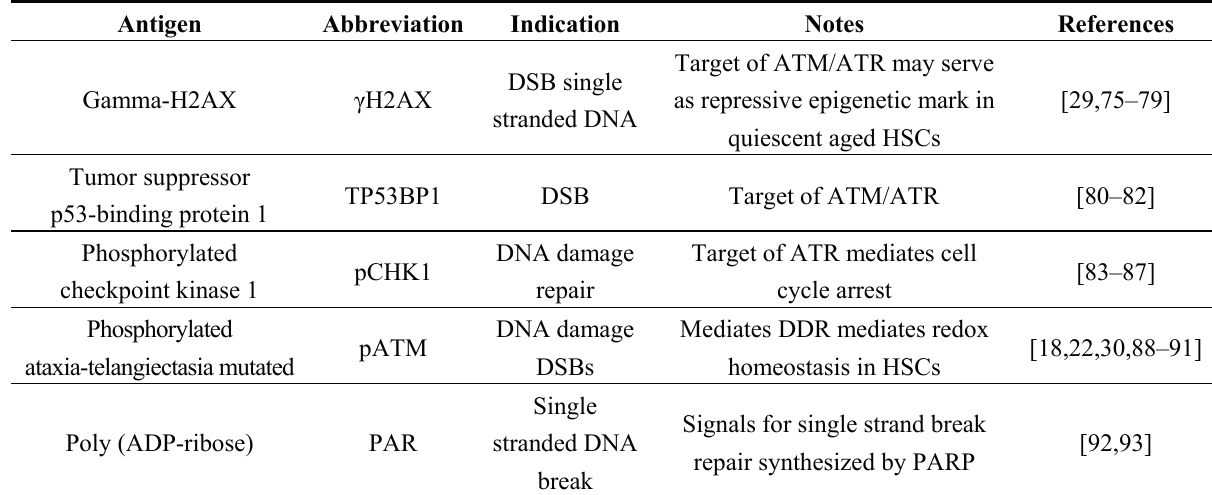
Table 1. DNA damage and DDR associated molecules. Flach, et al. utilized a variety of antigens to examine DNA damage, DDR, replication stress and ribosome biosynthesis by immunofluorescence [29]. A number of these markers are reproduced and described